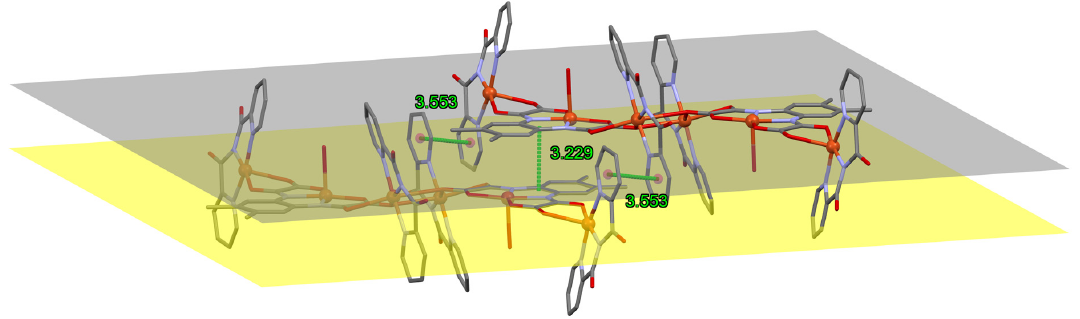
Figure 4. Centrosymmetrically related pair of hexanuclear units highlighting the π – π stacking involving bpca and dmopba ligands. The centroid distance (3.553 Å) between the closest bpca pyridyl rings, as well as the distance (3.229 Å) between the least-squares plane through the closest [Cu(dmopba)(H 2 O)] 2 − moieties (in gray and yellow) are depicted as dashed green lines. Hydrogen atoms were omitted for clarity.